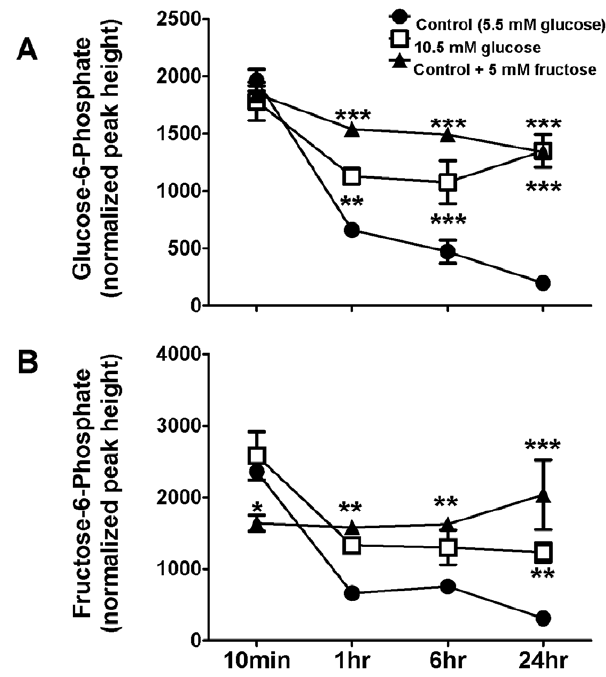
Figure 5. Changes in hexose-6-phosphate levels in HepG2 cells grown in glucose or fructose. ( A ) Abundance of G-6-P in HepG2 cells grown in 5.5 mM glucose (control), 10. 5 mM glucose, or glucose + 5 mM fructose for 48 hours before new media was added for 10 min, 1 hr, 6 hr, or 24 hr. ( B ) Levels of fructose-6-phosphate (F-6- P) in HepG2 cells grown in the three conditions described above. Units of intensity are quantifier ion peak heights. Means 6 SEM are depicted. *P , 0.05, **P , 0.01, ***P , 0.001 vs. controls; n=5 or 6/group.